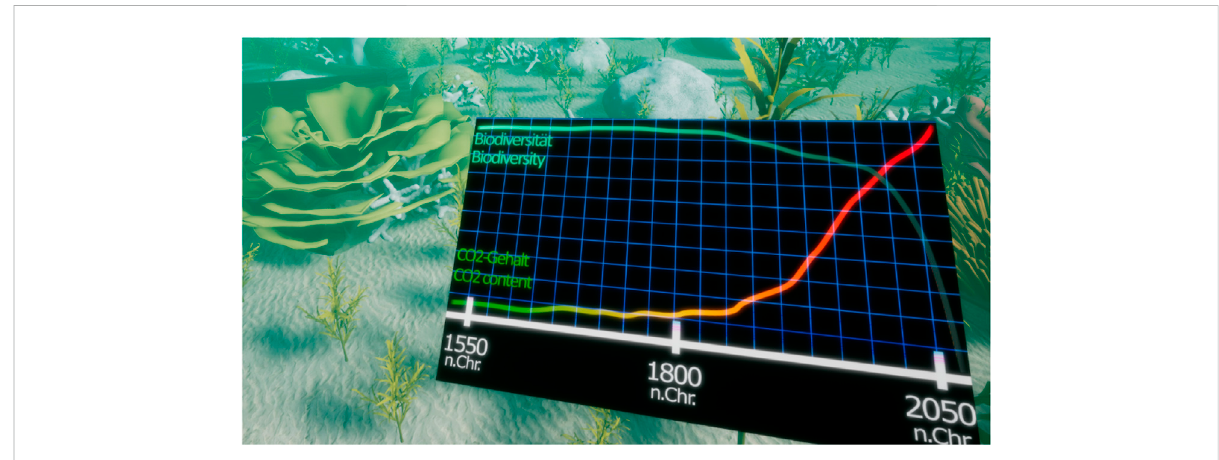
FIGURE 6 In addition to obvious environmental changes in the decaying coral reef, we included a chart visualizing the reef ’ s health on a virtual screen, which participants could bring up very easily by fl icking their left wrist.